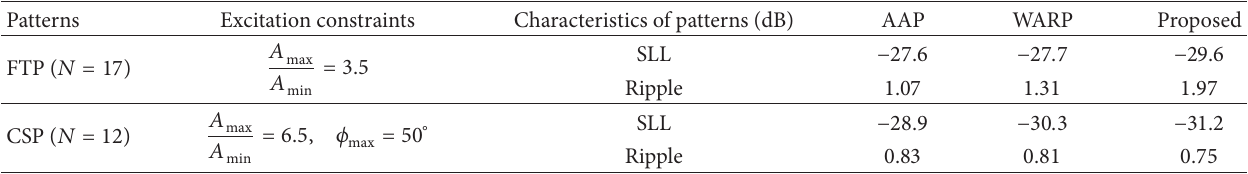
Table 3: Comparison of different methods for FTP and CSP